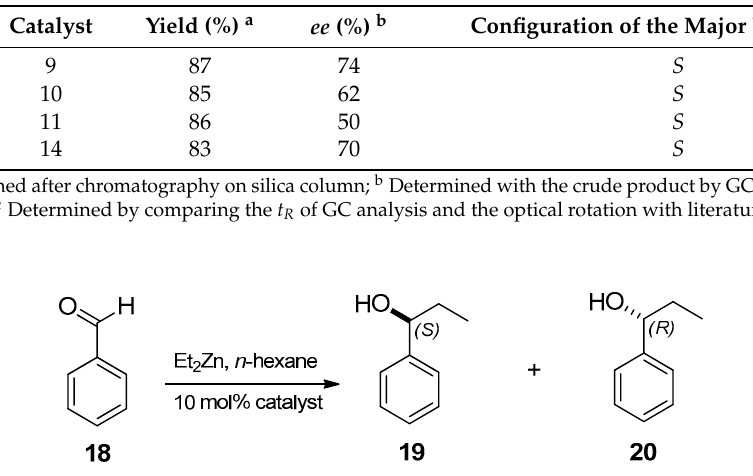
Scheme 4. Model reaction for enantioselective catalysis.